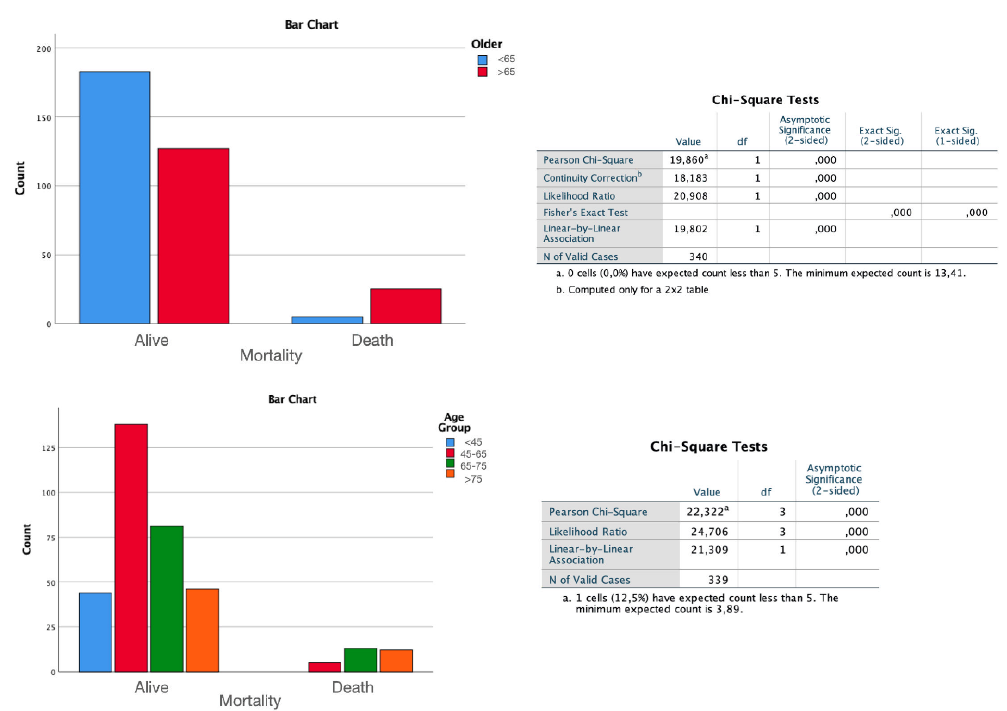
Figure 8. Bar chart of the ANOVA study shows that the difference in mortality at last evaluation is maintained even when analyzing rates over the four age subdivisions ( p < 0.01), thus showing no differences in the groups between 65 – 75 and >75 years.